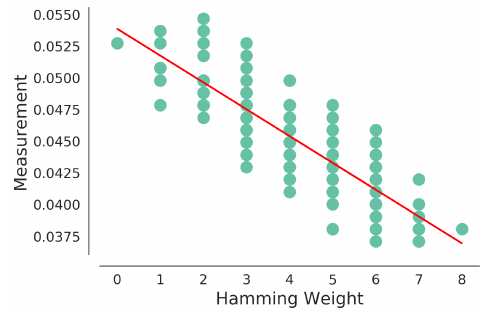
Figure 24: Measured leakages vs. actual Hamming weights on the